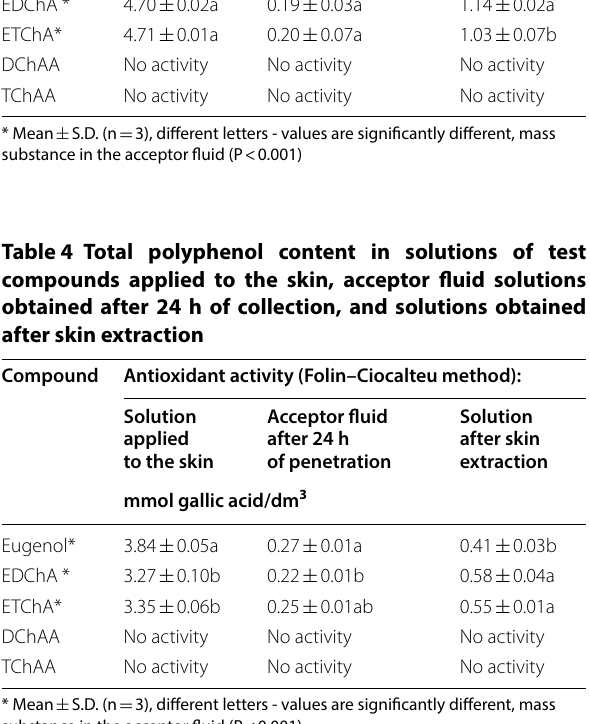
(Table 3). The results of studies on the antioxidant